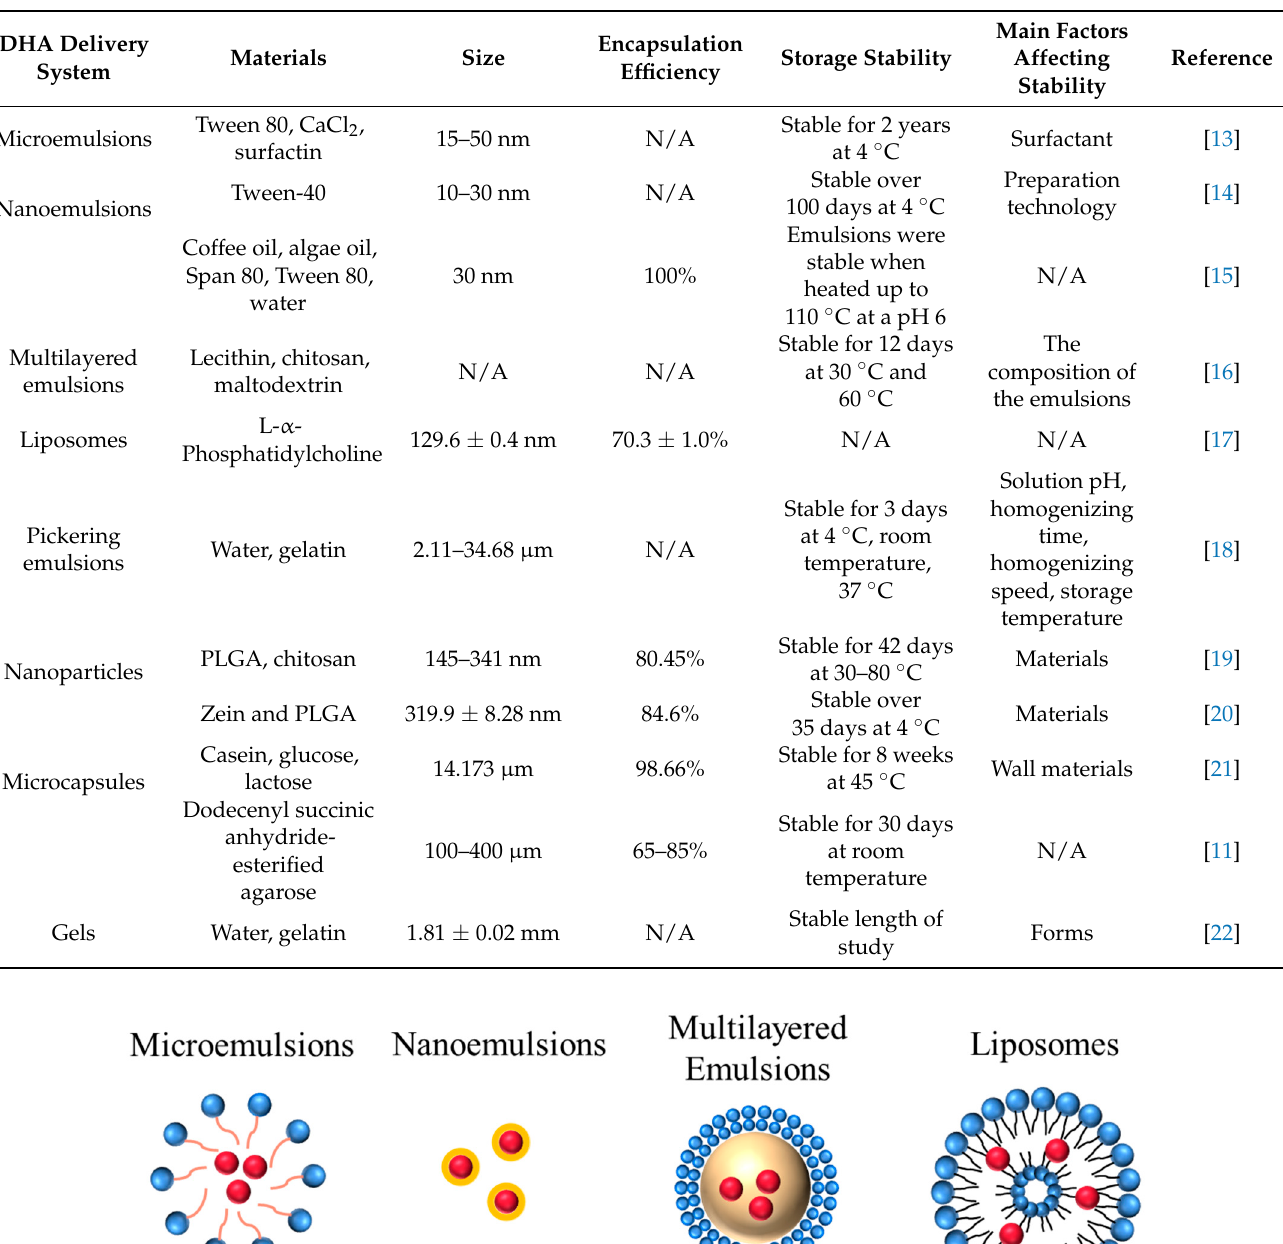
Table 1. Summary of DHA delivery systems.